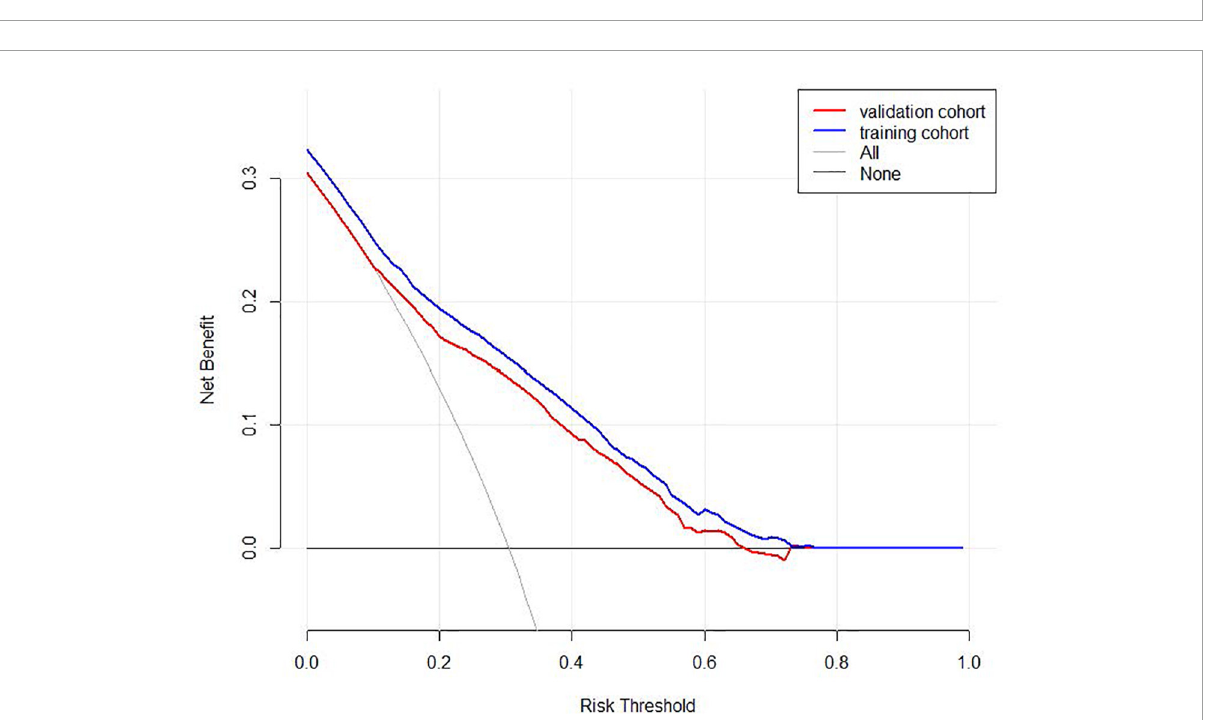
FIGURE5 Decision curve analysis for the predictive model. The net benefit was produced against the high-risk threshold. The red solid line represents the validation cohort. The blue solid line represents the training cohort. The decision curve shows that the incidence of poor sleep quality among medical students is 31.9%, and at the threshold of 31.9%, the decision curve is above the None line and the All line, so the model has clinical